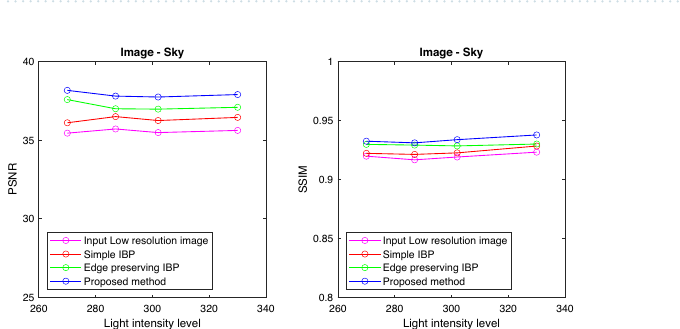
Figure 8. PSNR and SSIM plotted against light intensities—Building image.